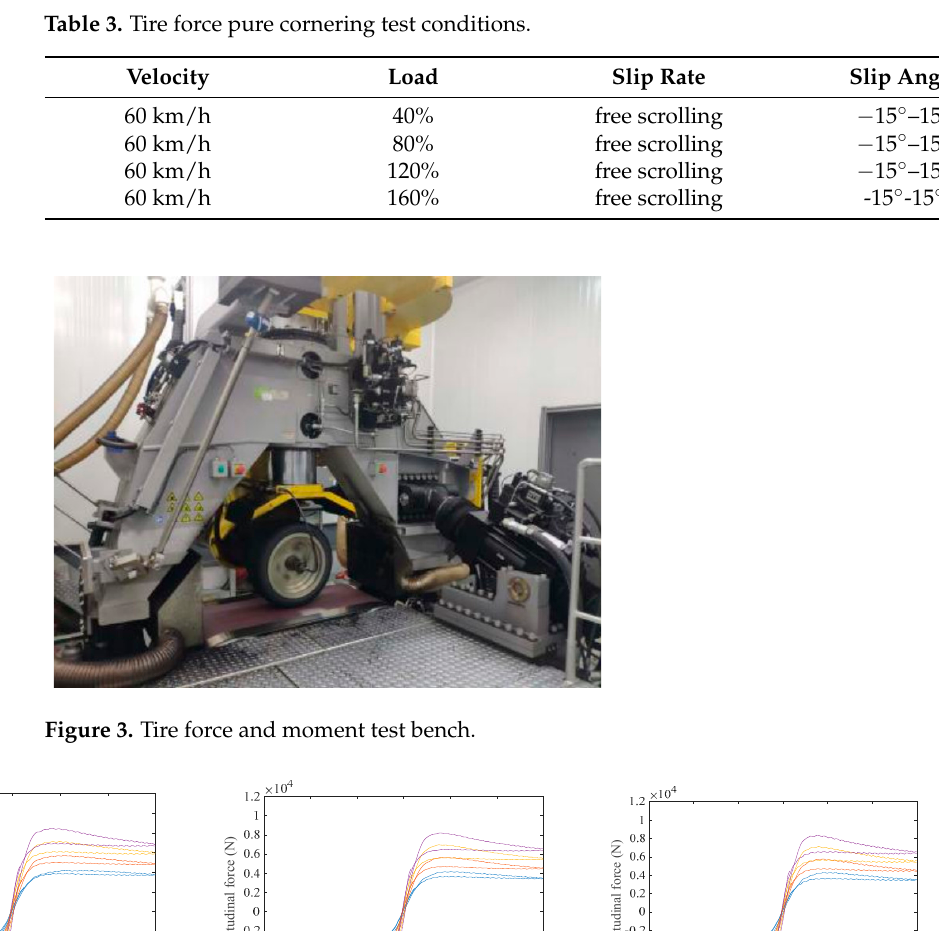
Figure 4. Longitudinal force experiments with different camber angles. Table 3. Tire force pure cornering test conditions.